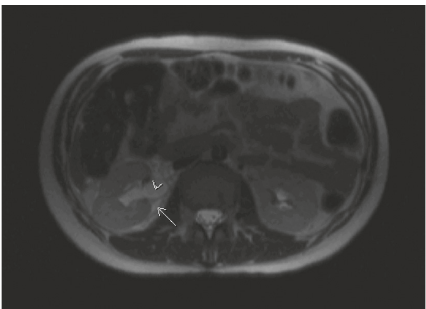
Figure 1: Coronal slice of MRI obtained on admission showing right hydroureter (arrowhead) and fluid extravasation surrounding the right kidney